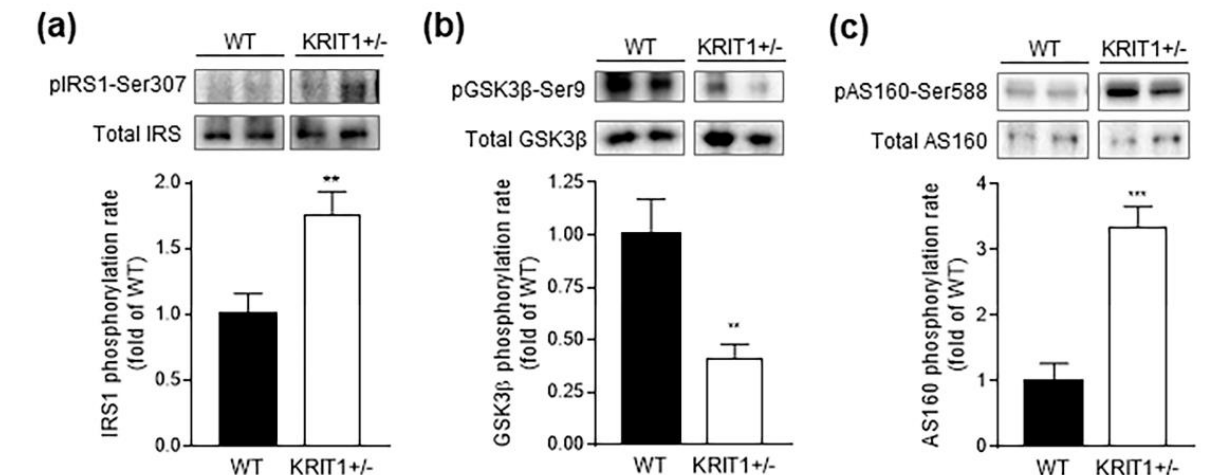
Figure 3. Heterozygous loss of KRIT1 in mice affected hepatic insulin signaling. ( a – c ) Represen- tative Western blots and related histograms showing significant differences in liver homogenates from KRIT1 heterozygous (KRIT1 +/ − ) vs. wild-type (WT) mice with respect to phosphorylation level of key regulatory proteins involved in insulin signaling, including a marked increase and decrease in inactivating phosphorylation of insulin receptor substrate 1 (pIRS1-Ser307) ( a ) and glycogen synthase kinase 3 β (pGSK3 β -Ser9) ( b ), respectively, and an equally marked increase in activating phosphory- lation of Akt substrate of 160 kDa (pAS160-Ser588) ( c ). The histograms represent the densitometric quantification of phosphorylated protein bands of 7 mice per group normalized to the corresponding total forms. Data are means ± SEM of 7 mice per group and are presented as fold changes relative to the WT control. ** p < 0.005; *** p < 0.001 vs.